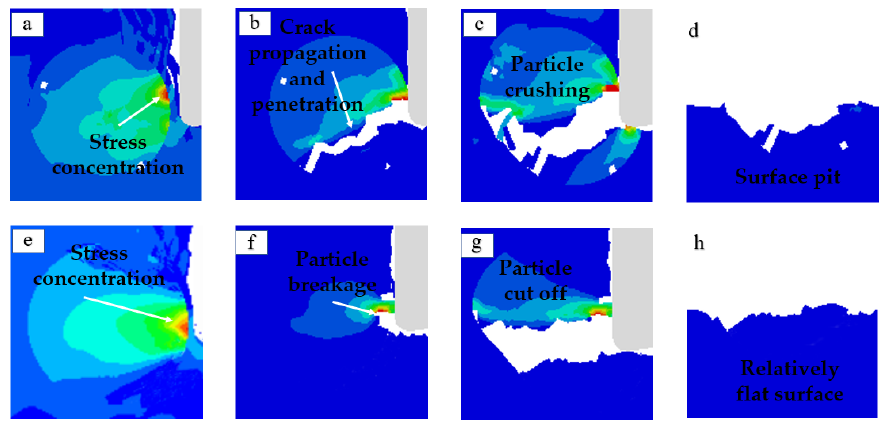
Figure 9. Simulation of TiC particle 2 failure removal process. ( a – d ) CCT. ( e – h ) UCT. Different colors represent the stress distribution, the brighter the color the more intense the stress concentration.